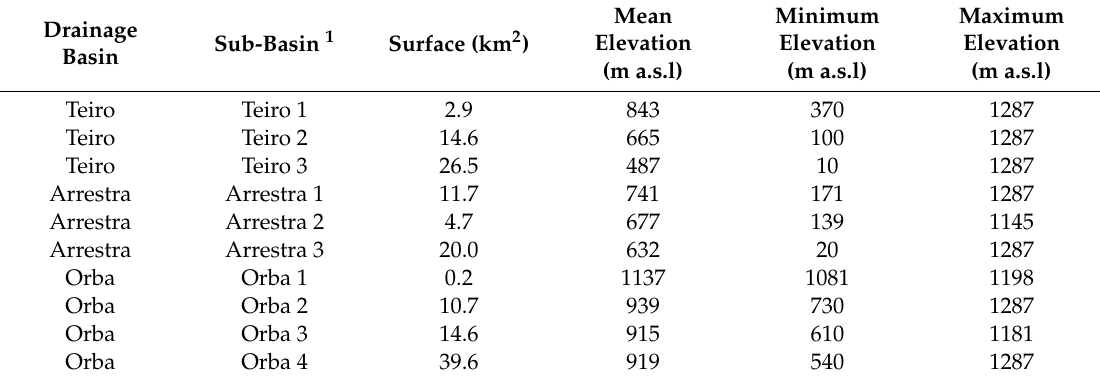
Table 1. Surface area and average elevation of drainage